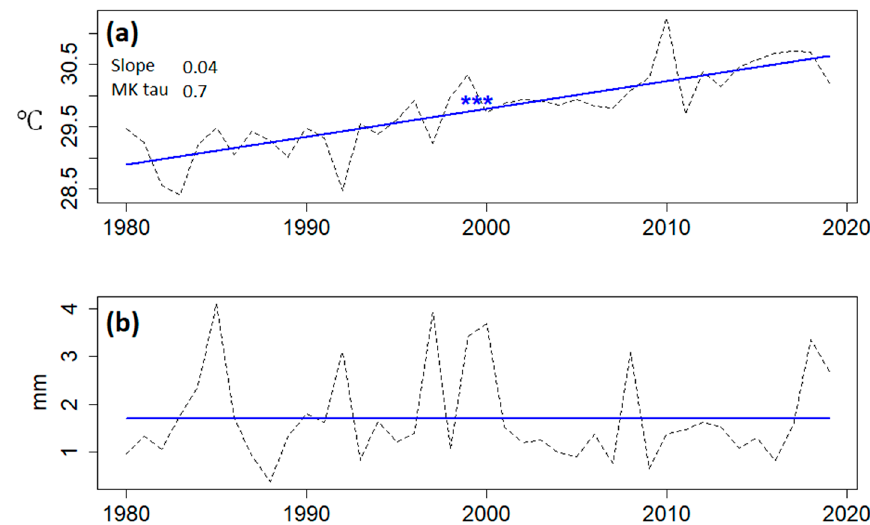
Figure 11. Trend (blue line) analysis for annual average ( a ) temperature and ( b ) rainfall. Trend for rainfall came out to be non-significant, therefore slope and MK (Mann-Kendall) tau values are not shown. The symbol * shows the trend is significant, with three * meaning highly significant having p value of less than 0.000001.